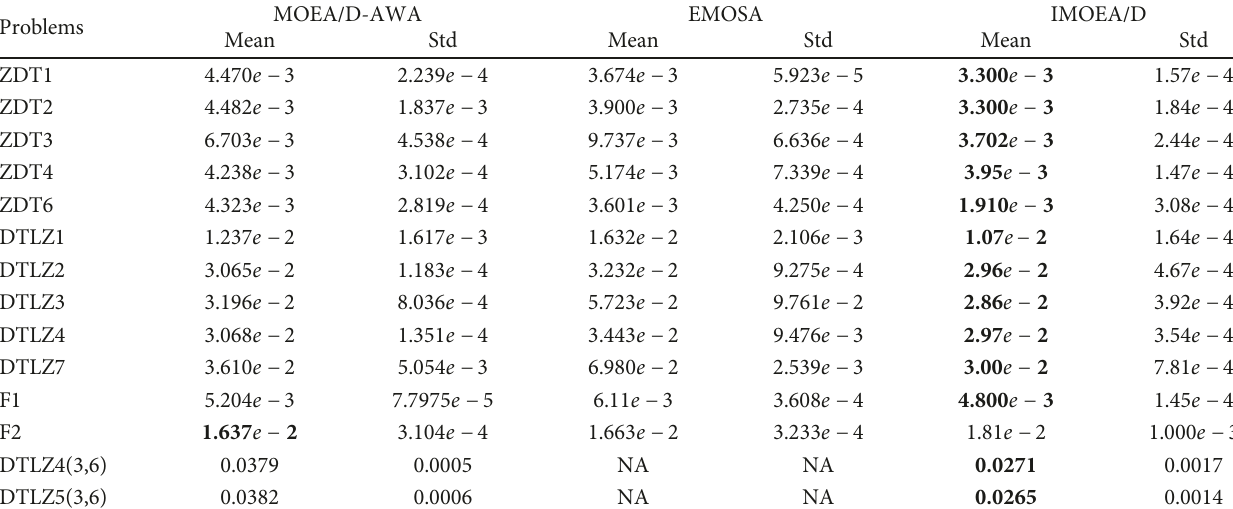
Table 3: IGD obtained by IMOEA/DA and